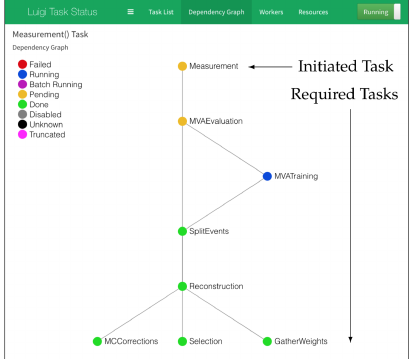
Figure 2: Screenshot of the Luigi web visual- izer application, showing a hypothetical analy- sis workflow consisting of an initiated task and its recursive requirements in a directed acyclic graph (DAG). Edges visualize direct depen- dencies and node colors denote task